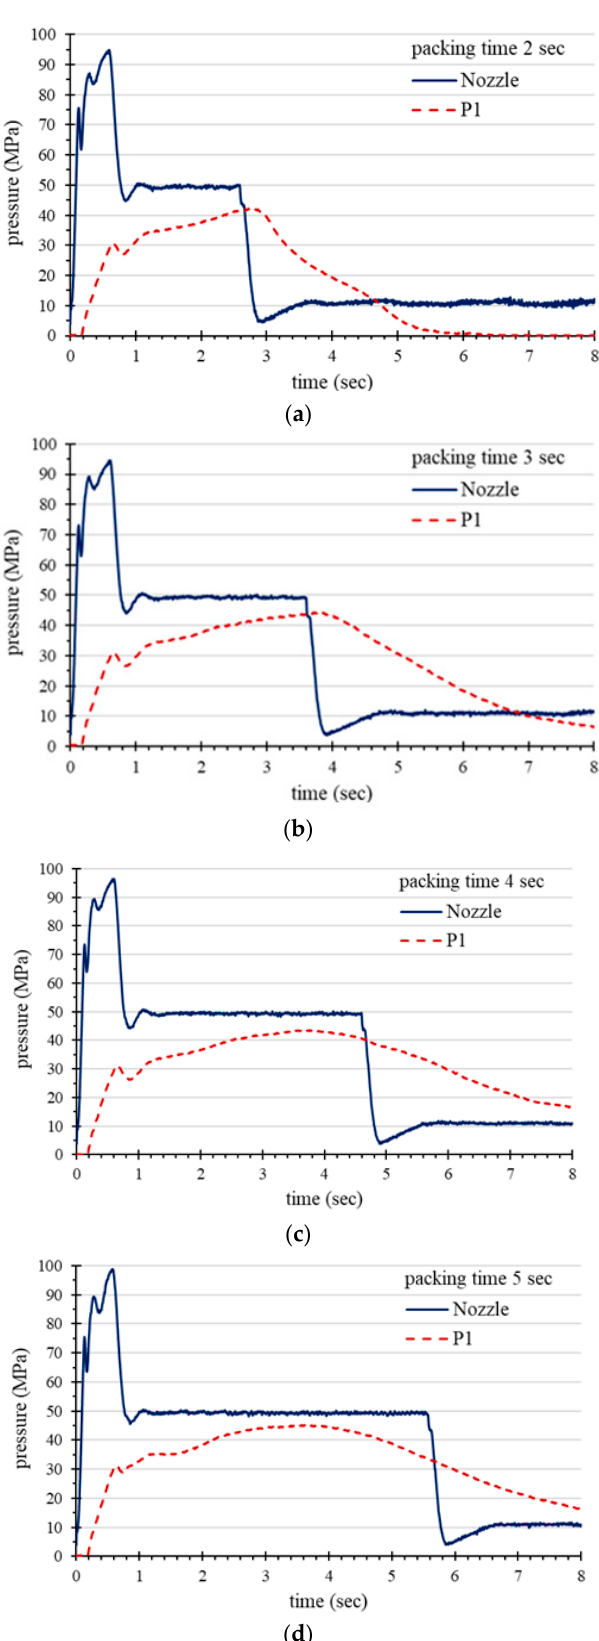
Figure 9. Pressure profiles w.r.t. various packing time: ( a ) 2 s, ( b ) 3 s, ( c ) 4 s, and ( d ) 5 s.